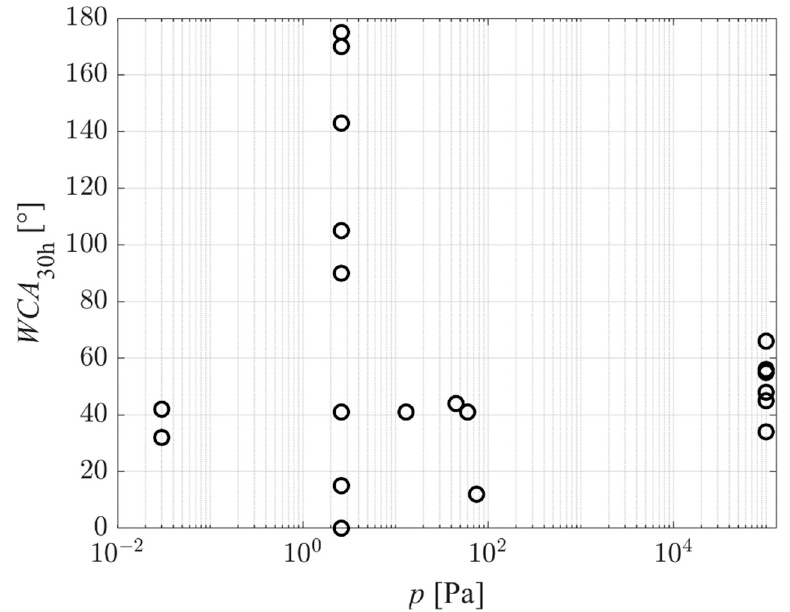
Figure 10. The WCA of PET samples after aging for 30 h versus the pressure in the plasma chamber.